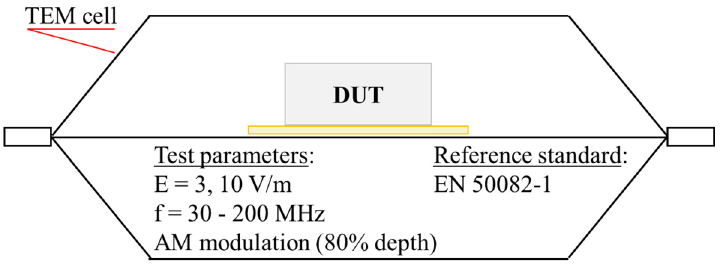
Figure 3. Device under test (DUT) position in the TEM cell.